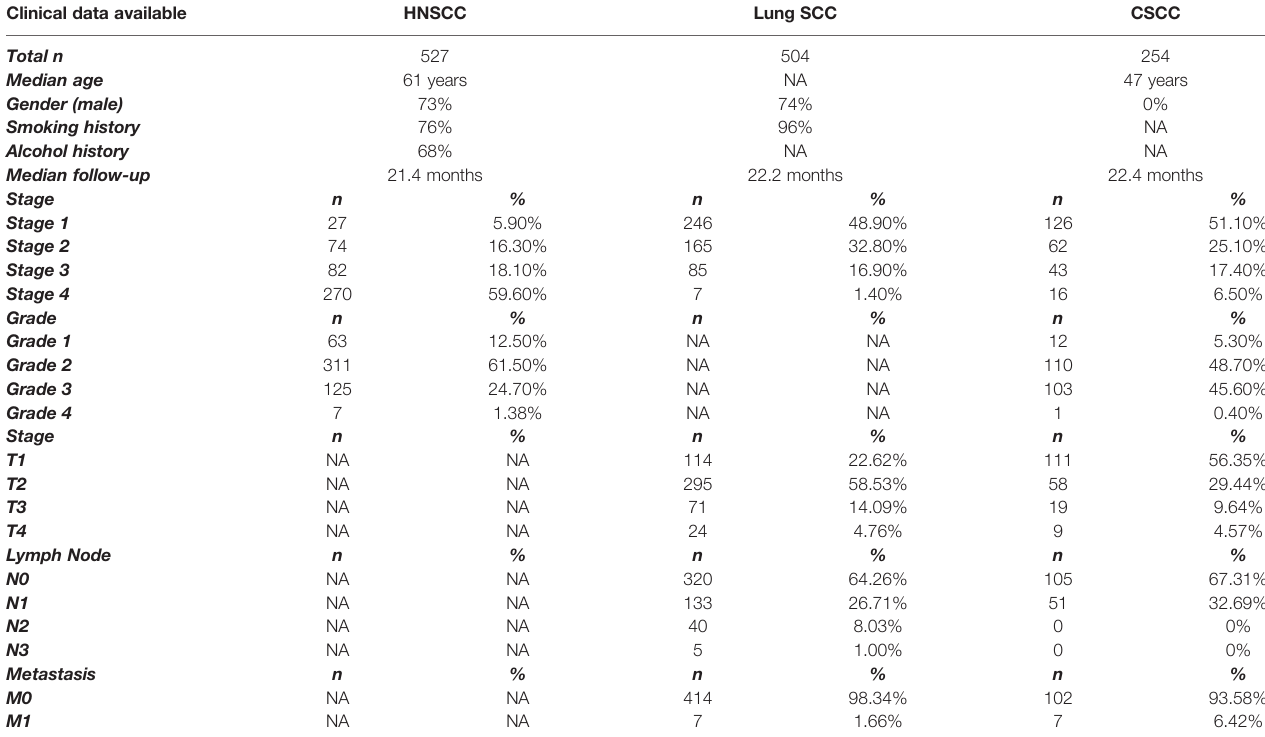
TABLE 1 | Patients ’ clinical characteristics. Clinical data